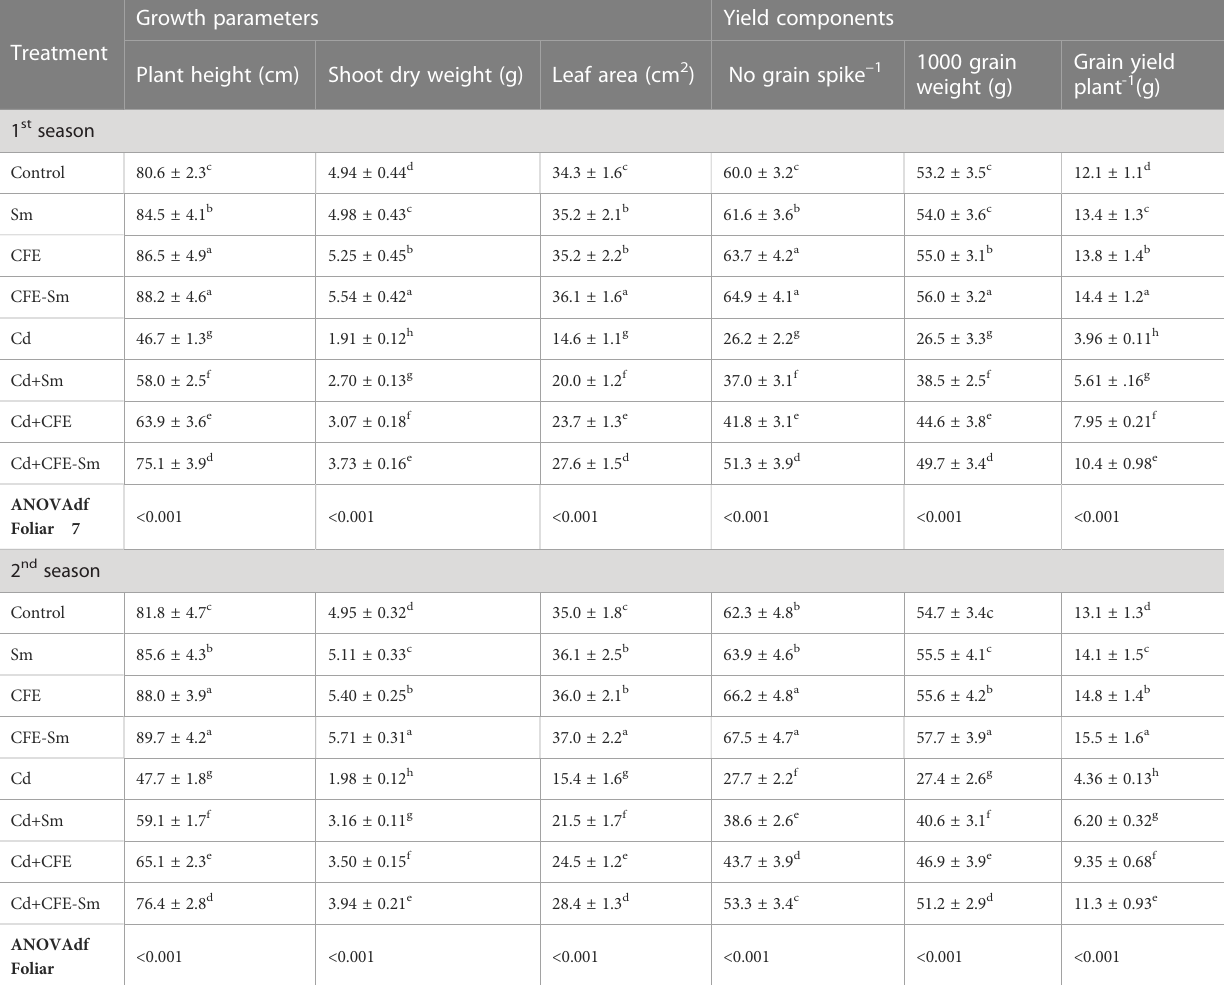
TABLE 2 Wheat plant growth parameters and yield components after foliar application of silymarin (Sm), clove fruit extract (CFE), and silymarin- enriched clove fruit extract (CFE-Sm) under Cd stress.